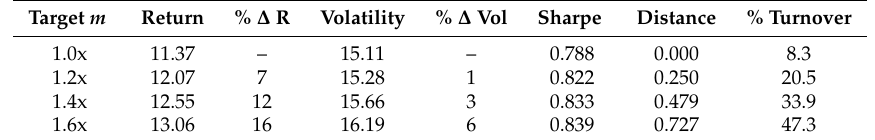
Table 6. Annualized Out-of-Sample Performance—Proposed Model.